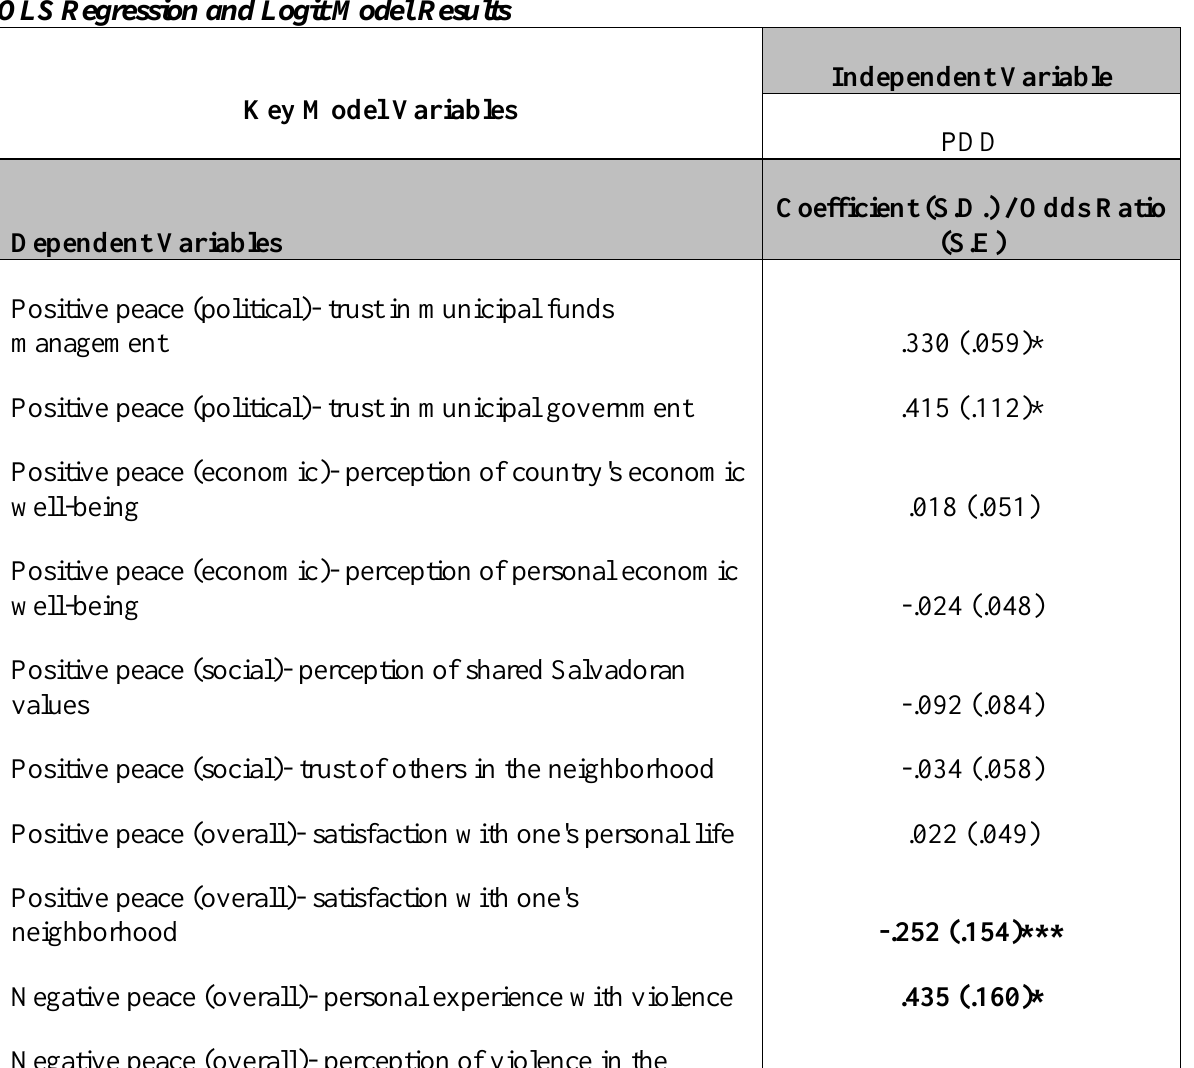
Table 2 OLS Regression and Logit Model